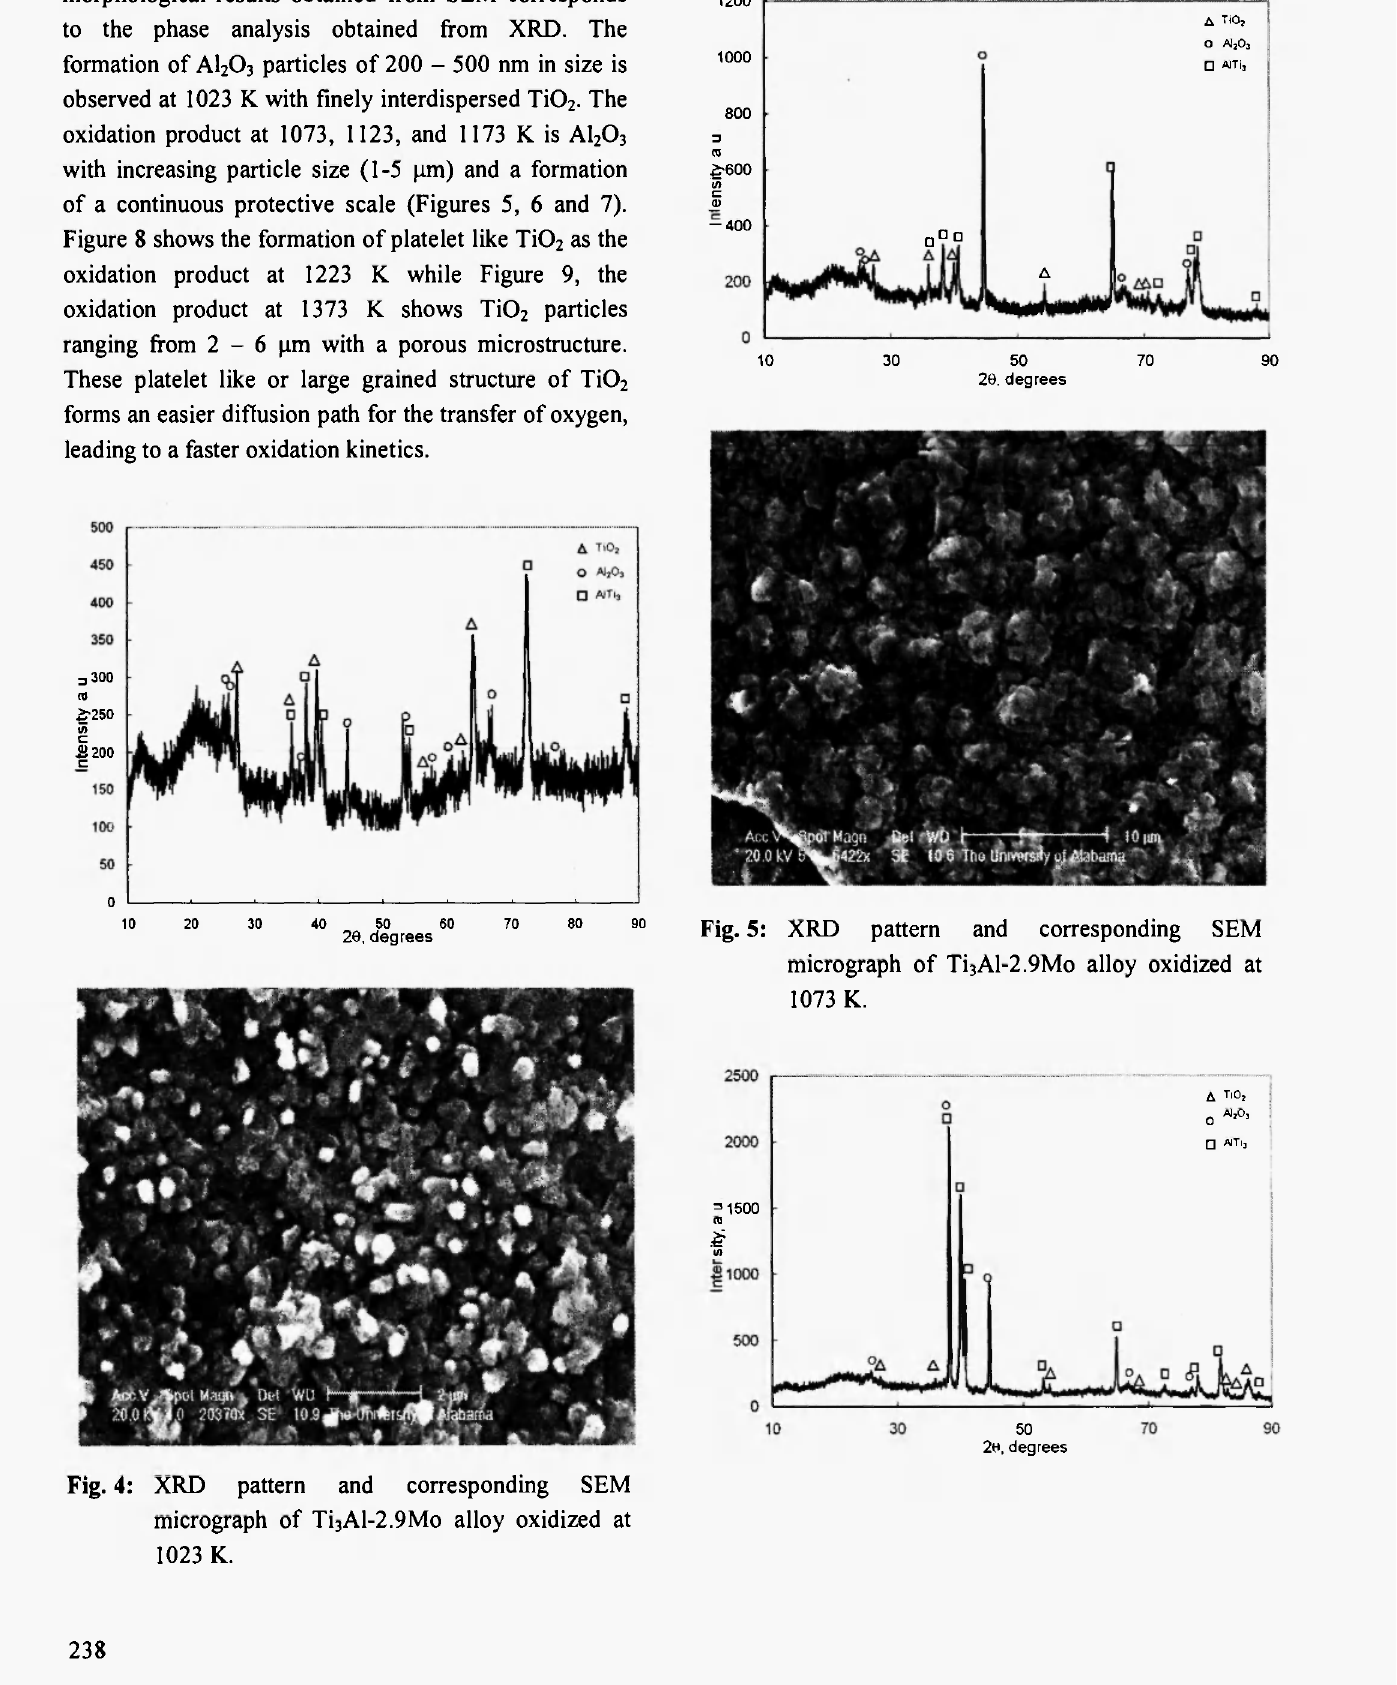
Fig. 5: XRD pattern and corresponding SEM micrograph of Ti 3 Al-2.9Mo alloy oxidized at 1073